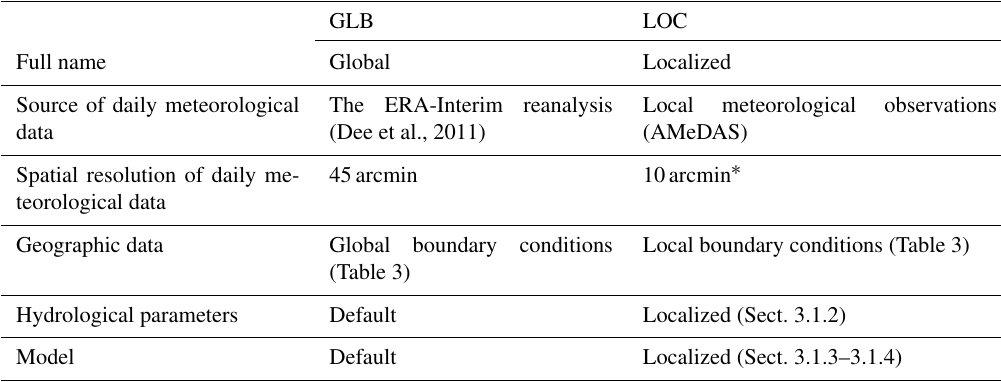
Table 5. Simulations. Key differences between the GLB and LOC simulations.